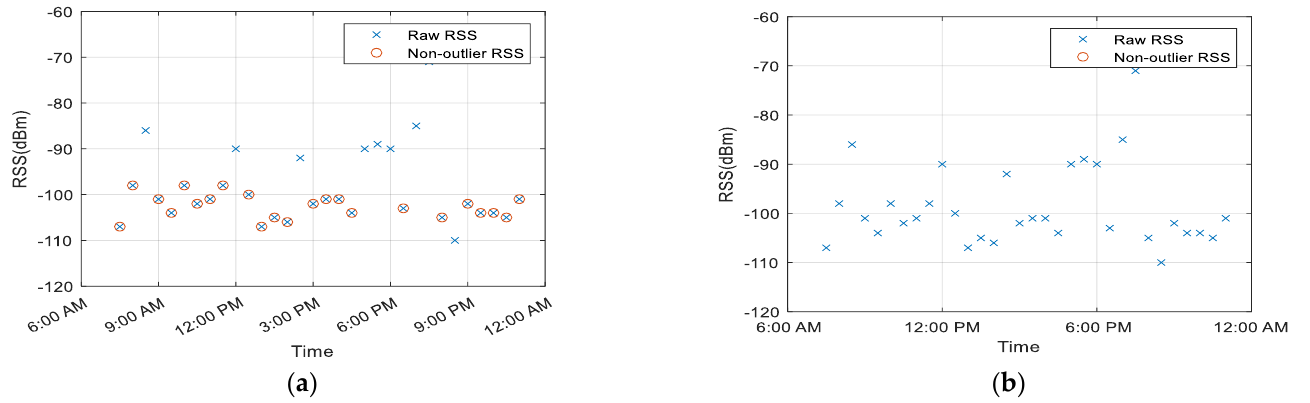
Figure 6. RSS outlier detection comparison for RSS Dataset 4. ( a ) 𝑆 𝑛 scale estimator, and ( b ) MAD scale estimator.